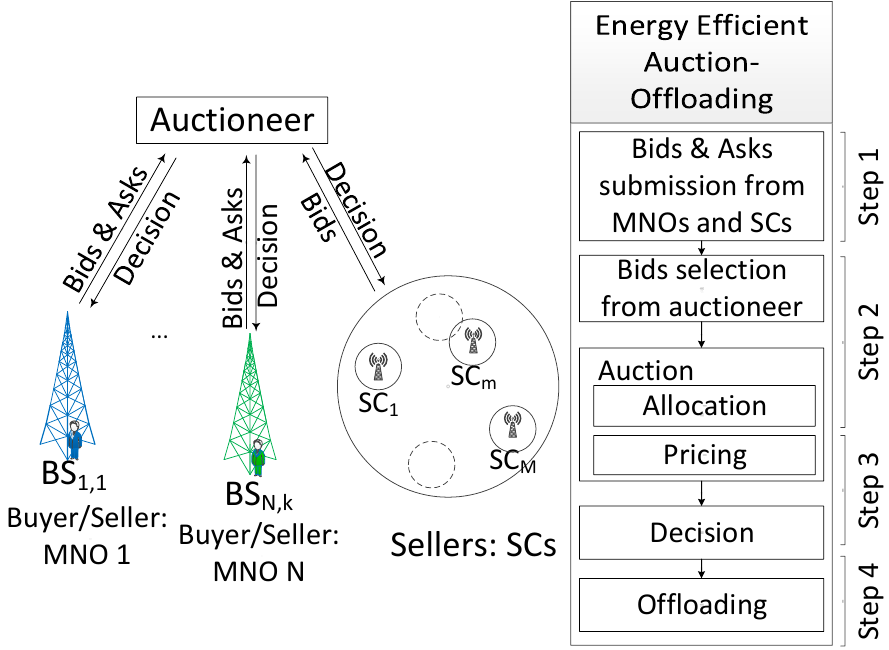
Figure 2. Auction illustration and proposed algorithm